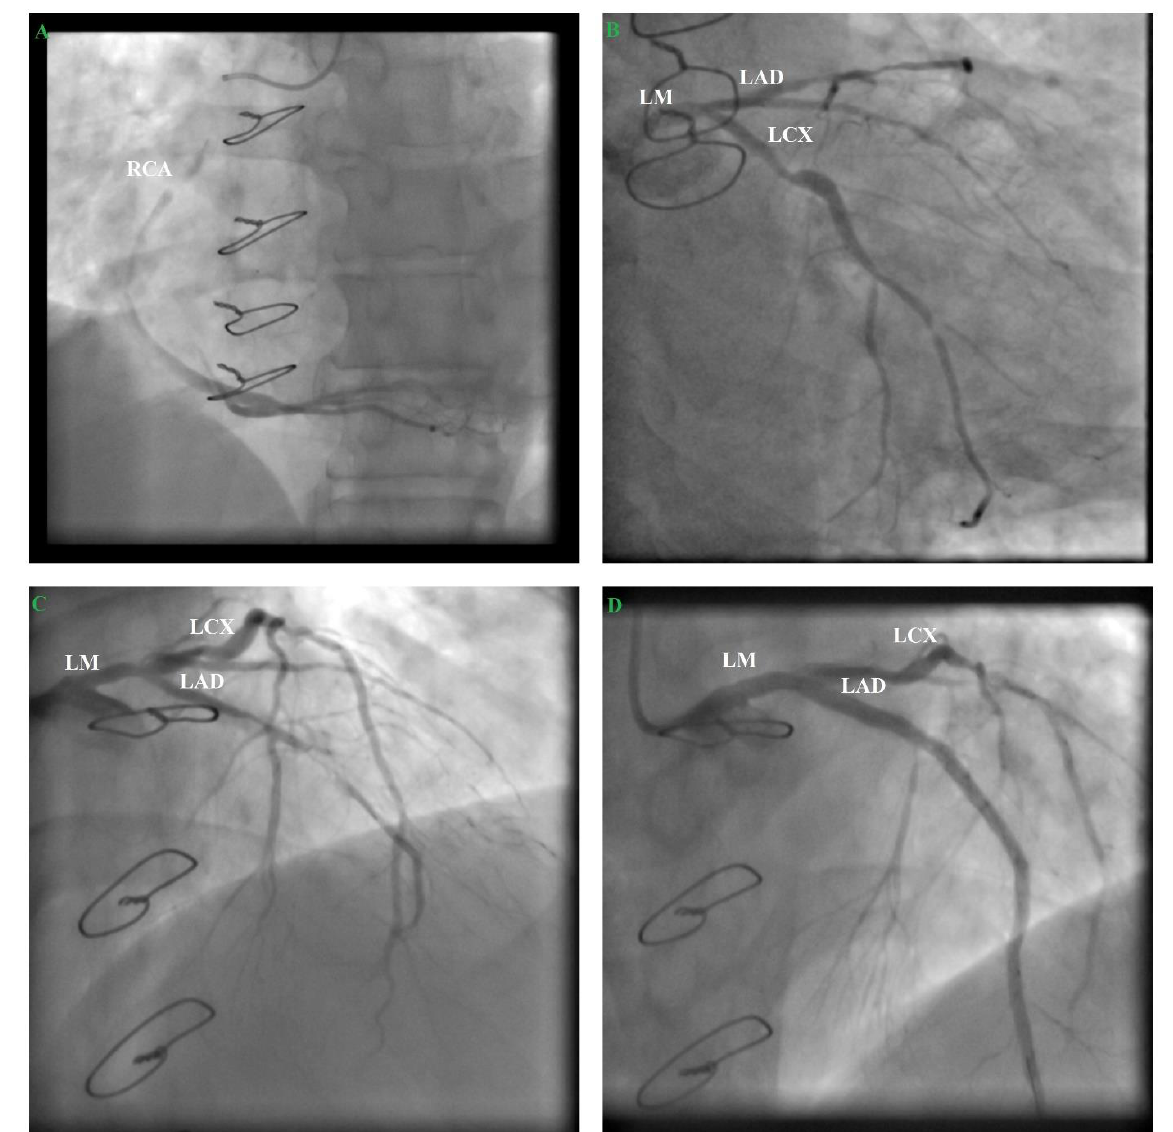
Figure 4. Percutaneous coronary intervention (PCI). ( A ) Cranial projection of the right coronary artery (RCA) showing 80% stenosis of the internal saphenous vein to the third segment of the right coronary artery; ( B ) Caudal projection of the left coronary artery showing a multiple 50–60% stenosis in the three segments of the left circumflex artery (LCX), 60–70% stenosis in the proximal segment of obtuse marginal 1 (OM1), and 50% stenosis in the distal segment of left main (LM); ( C ) Cranial projection of the left coronary showing occlusion of the internal saphenous vein to the first diagonal artery and 95% stenosis of the internal saphenous vein to LAD; ( D ) From distality to proximity—three DES on the whole LAD + one DES between the LM and LAD proximity, TIMI 3 flow.